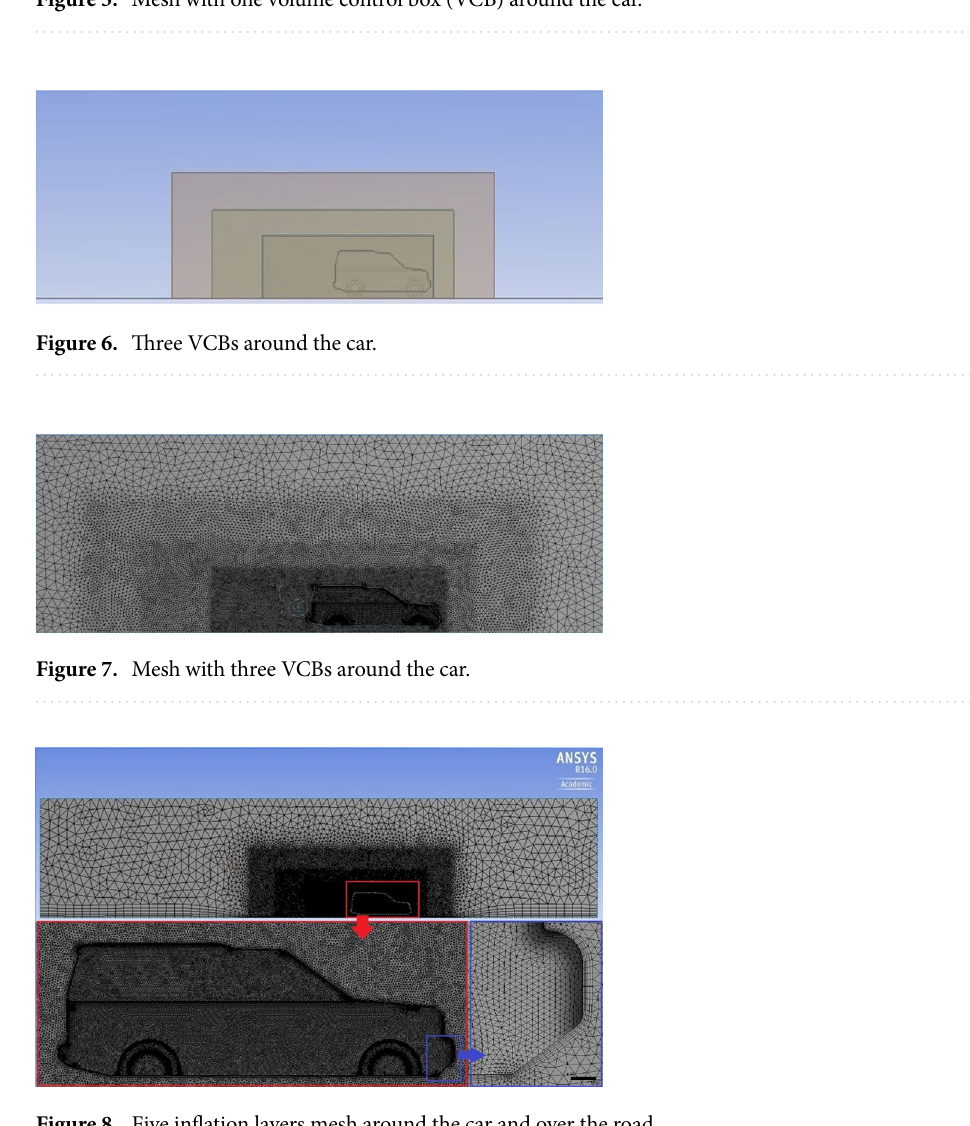
Figure 5. Mesh with one volume control box (VCB) around the car.